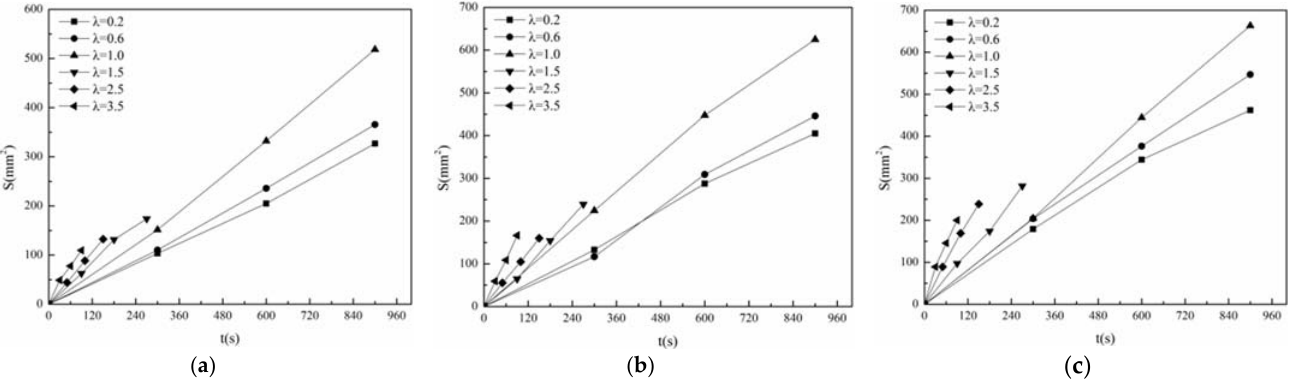
Figure 9. Icing areas covering the cylinder surfaces with different diameters: ( a ) d = 20 mm; ( b ) d = 30 mm; ( c ) d = 40 mm.